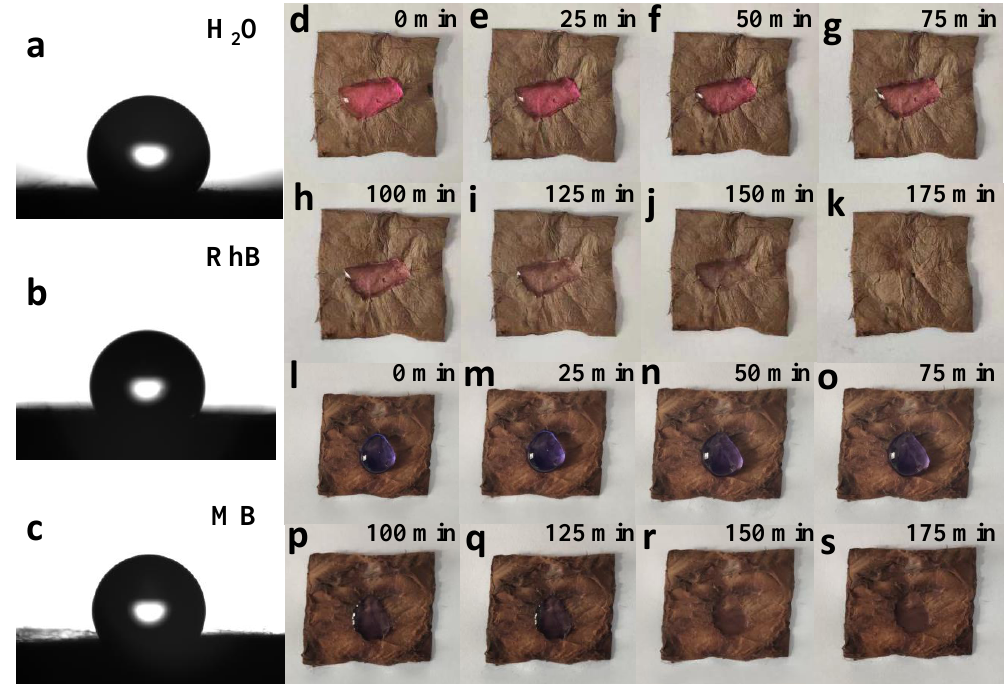
Figure 13. The optical images taken while the water and dye droplets come into contact to the surface of TiO 2 /PVDF@MoS 2 core-shell heterostructured fibers ( a – c ). Photographs of the RhB ( d – k ) and MB ( l – s ) droplet on the surface of TiO 2 /PVDF@MoS 2 core-shell heterostructured fibers under visible light illumination.